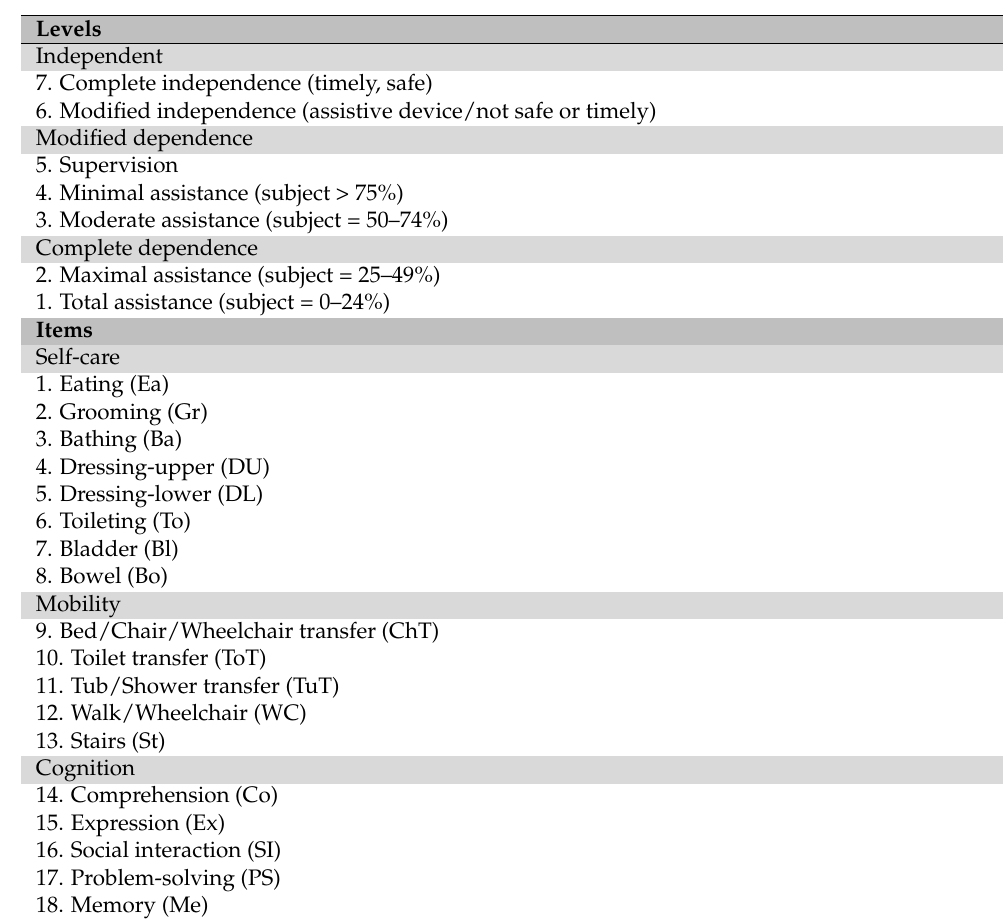
Table 1. Scores and items of the WeeFIM